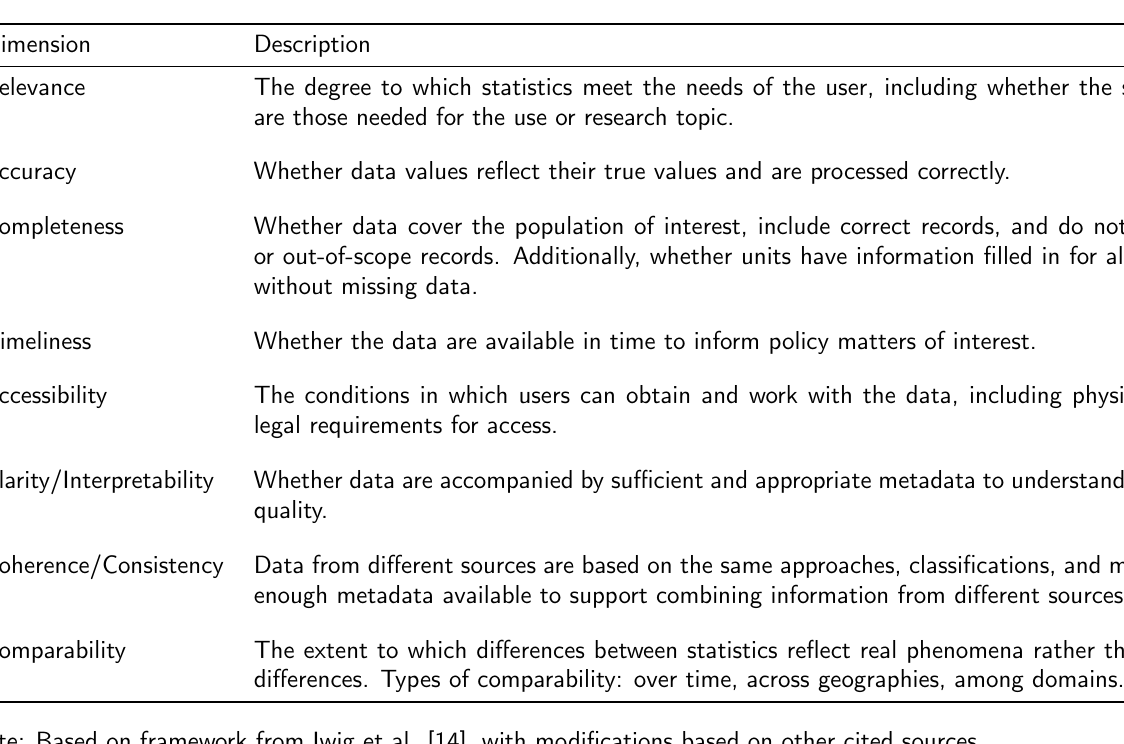
Table 1: Dimensions for evaluating administrative data